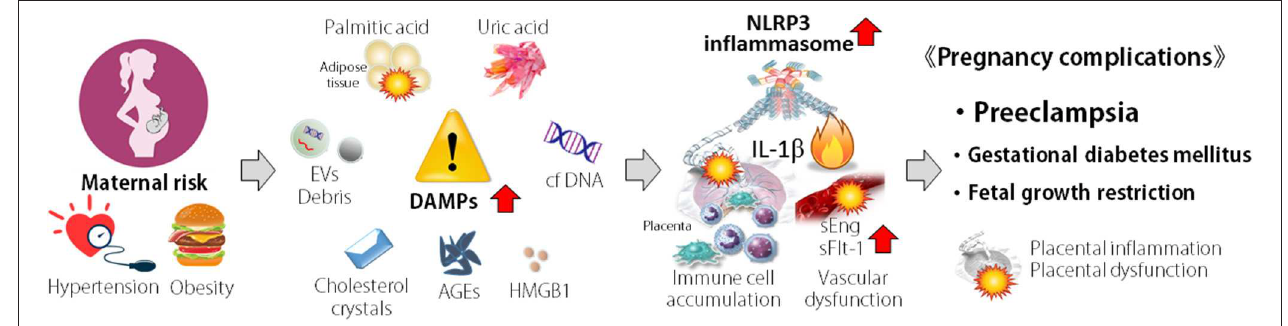
FIGURE 2 | Concept of association of NLRP3 inflammasome in pathogenesis of pregnancy complications. Maternal risk such as hypertension and obesity are associated with the elevation of damage-associated molecular patterns (DAMPs). DAMPs activate NLRP3 inflammasome, accumulate immune cells, and induce inflammatory cytokine production and vascular dysfunction in placenta. These events result in placental inflammation and dysfunction, leading to pregnancy complications, such as preeclampsia, spontaneous abortion, recurrent pregnancy loss, and fetal growth